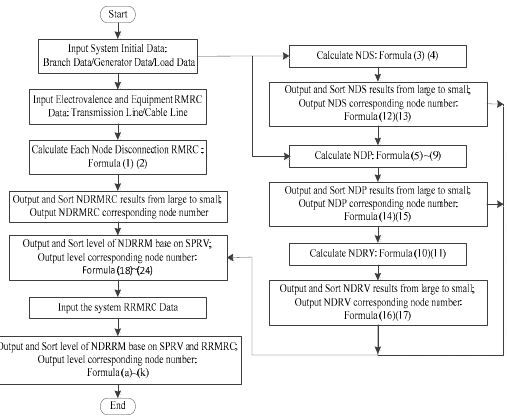
Figure 2. Process of the node disconnection risk rating method.